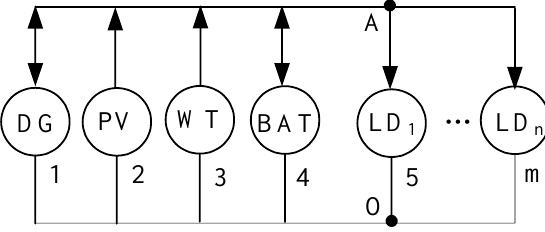
Figure 2. Energy circuit diagram.